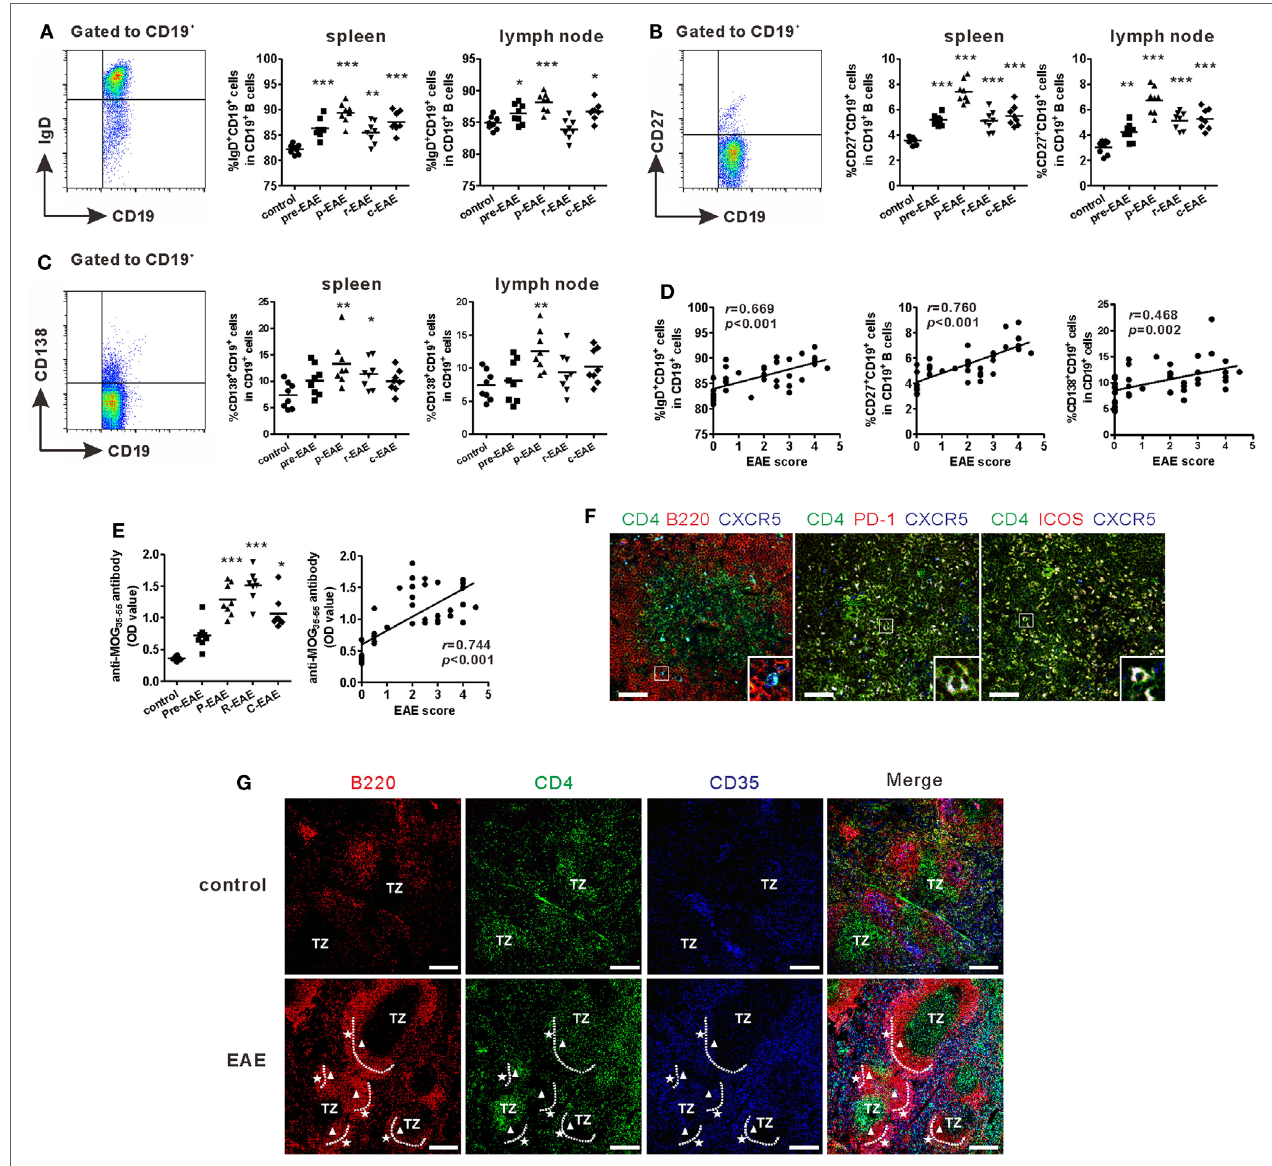
FigUre 3 | B cell profile and morphology of germinal centers (GCs) in experimental autoimmune encephalomyelitis (EAE) mice. Comparisons of the frequencies of CD19 + IgD + mature B cells (a) , CD19 + CD27 + memory B cells (B) , and CD19 + CD138 + plasma cells (c) in the spleen and draining lymph nodes at different phases of EAE mice. (D) The correlation analysis between each of the three subsets in the spleen mentioned above and EAE score, respectively. (e) The serum level of anti-MOG 35–55 antibodies (represented as OD value) at different phases of EAE mice and its correlation with EAE score. For (a–e) , each data point represents an individual subject and the horizontal lines represent the means ( n = 8/time point). Results are representative of three independent experiments. Abbreviations: Pre, pre-clinical; P, peak; R, remission; C, chronic. * P < 0.05, ** P < 0.01, *** P < 0.001 vs. control. (F) Immunofluorescence staining of the spleen of EAE mice showed T follicular helper-like cells located at the T-B border (bar = 50 μ m). (g) Immunofluorescence staining compared the GC structures between the spleen of control and EAE mice (TZ = T-cell zone, white triangle: dark zone, white pentacle: light zone, bar = 200 μ m). Sections are representative of three mice